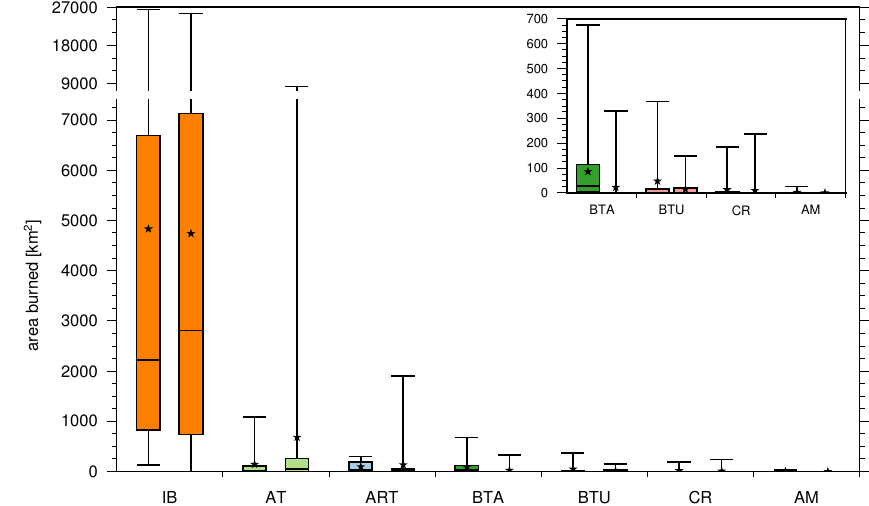
Fig. 6. Boxplots showing the observed (left box plot) and simulated (right box plot) minimum, maximum, median and quartiles of area burned between 1986 and 2010 for each of the seven ecoregions. Black stars indicate the statistical mean value.